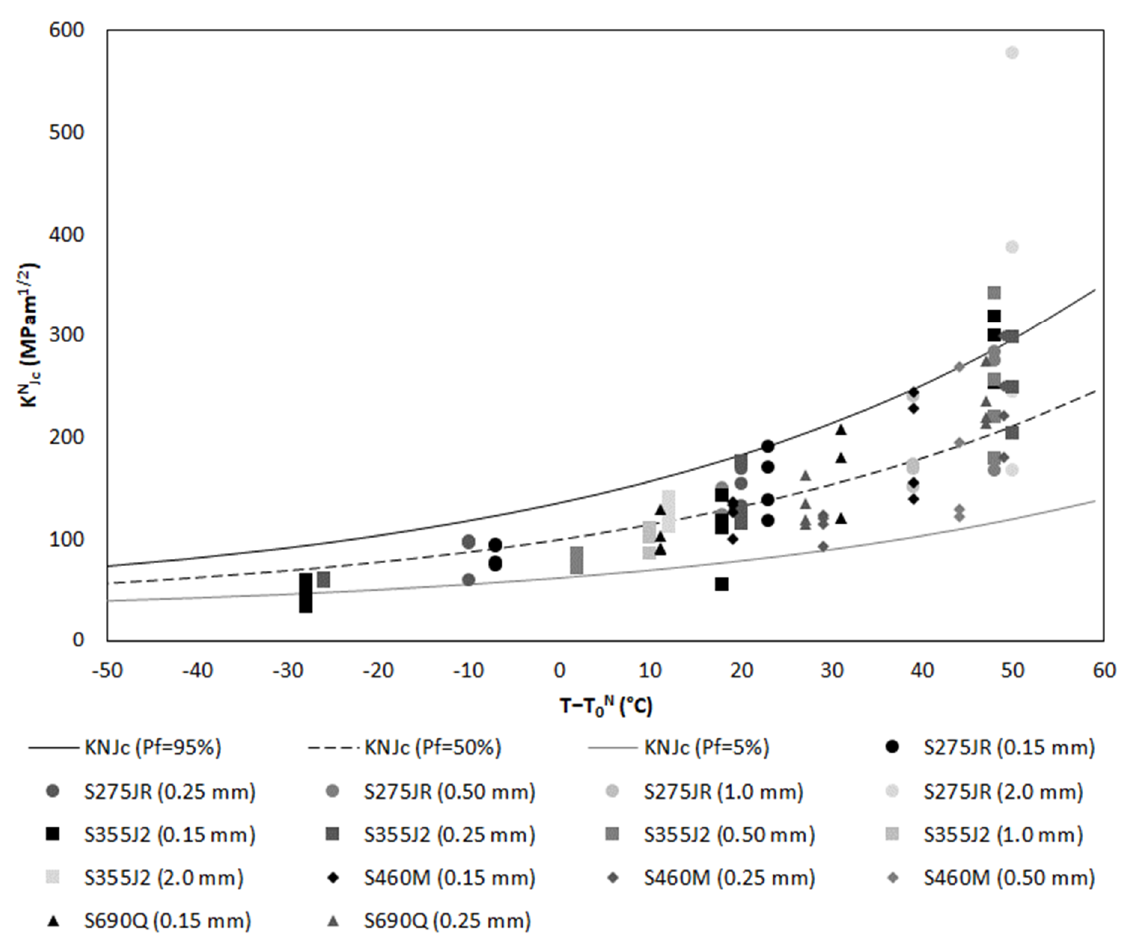
Figure 8. Comparison between apparent fracture toughness (K N Jc ) experimental results obtained in notched structural steels (S275JR, S355J2, S460M and S690Q) and master curve predictions.